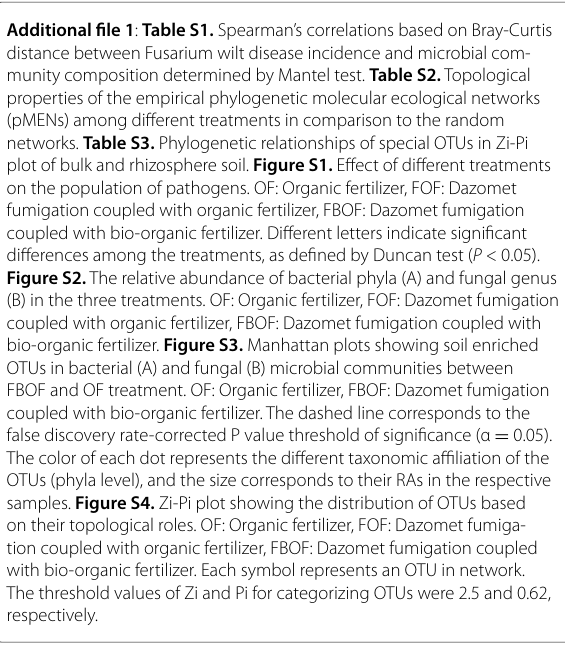
bio-organic fertilizer. Figure S3. Manhattan plots showing soil enriched OTUs in bacterial (A) and fungal (B) microbial communities between FBOF and OF treatment. OF: Organic fertilizer, FBOF: Dazomet fumigation coupled with bio-organic fertilizer. The dashed line corresponds to the false discovery rate-corrected P value threshold of significance (α The color of each dot represents the different taxonomic affiliation of the OTUs (phyla level), and the size corresponds to their RAs in the respective samples. Figure S4. Zi-Pi plot showing the distribution of OTUs based on their topological roles. OF: Organic fertilizer, FOF: Dazomet fumiga- tion coupled with organic fertilizer, FBOF: Dazomet fumigation coupled with bio-organic fertilizer. Each symbol represents an OTU in network. The threshold values of Zi and Pi for categorizing OTUs were 2.5 and 0.62,